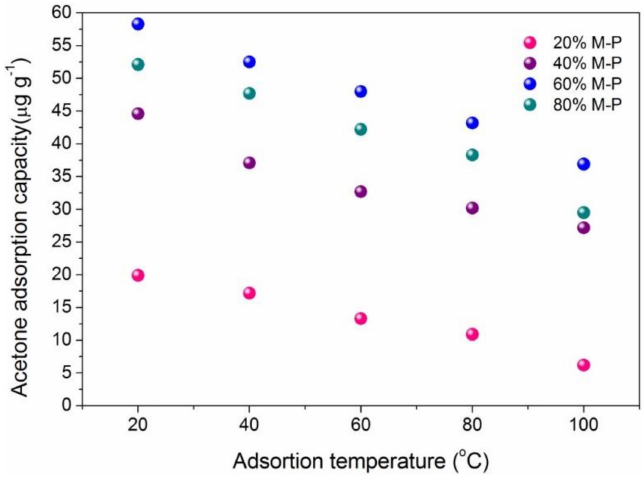
Figure 11. The influence of temperature on equilibrium acetone adsorption capacity of honeycomb fibers ( n =